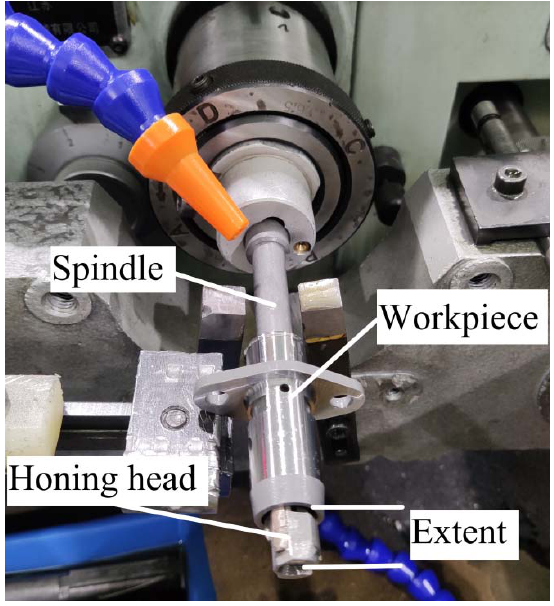
Figure 1. Honing experimental equipment.